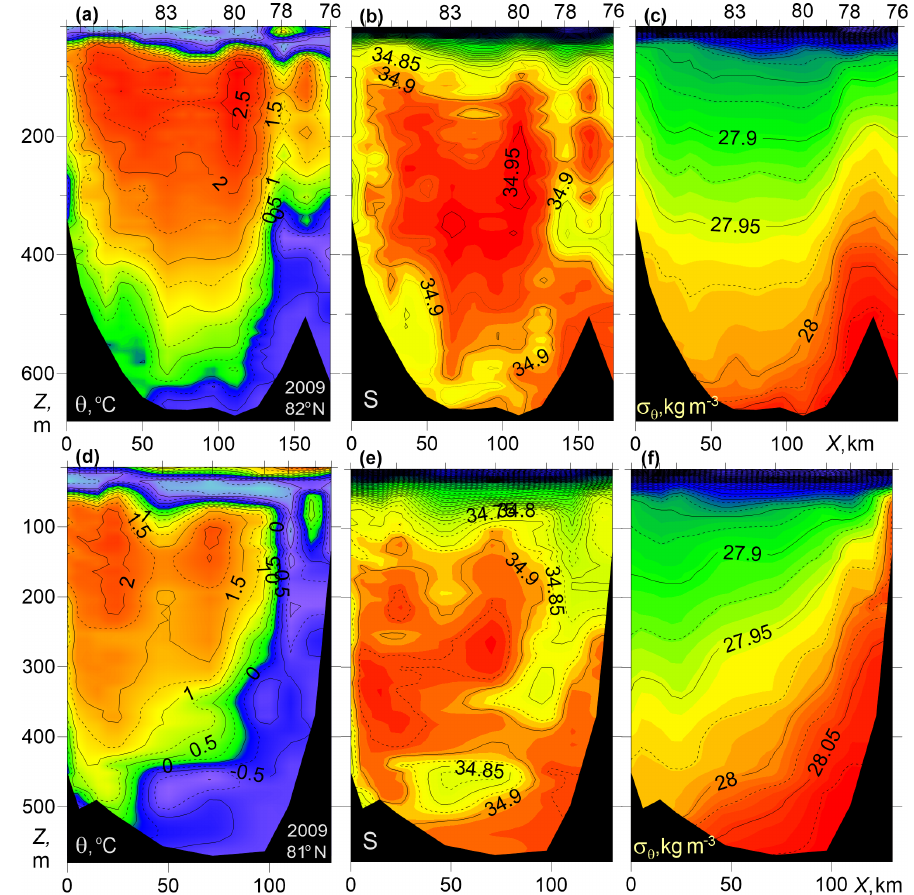
Figure 3. Temperature θ , salinity S , and potential density anomaly σ θ vs. distance and depth for zonal transects across the St. Anna Trough at latitudes of 81 ◦ N ( d–f , NABOS09) and 82 ◦ N ( a–c , NABOS09). The x axis is directed to the east. Numbers at the top indicate numbers of the CTD